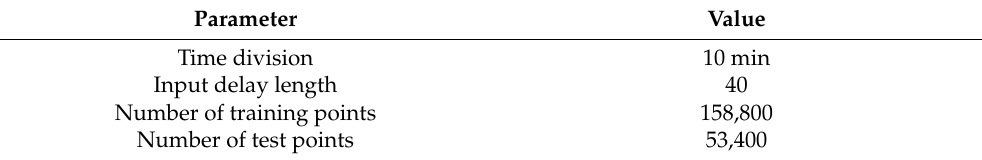
Table 9. The 2nd network configuration values (when evaluating the impact of number of hidden layers). Parameter Value Time division 10 min Input delay length 40 Number of training points 158,800 Number of test points